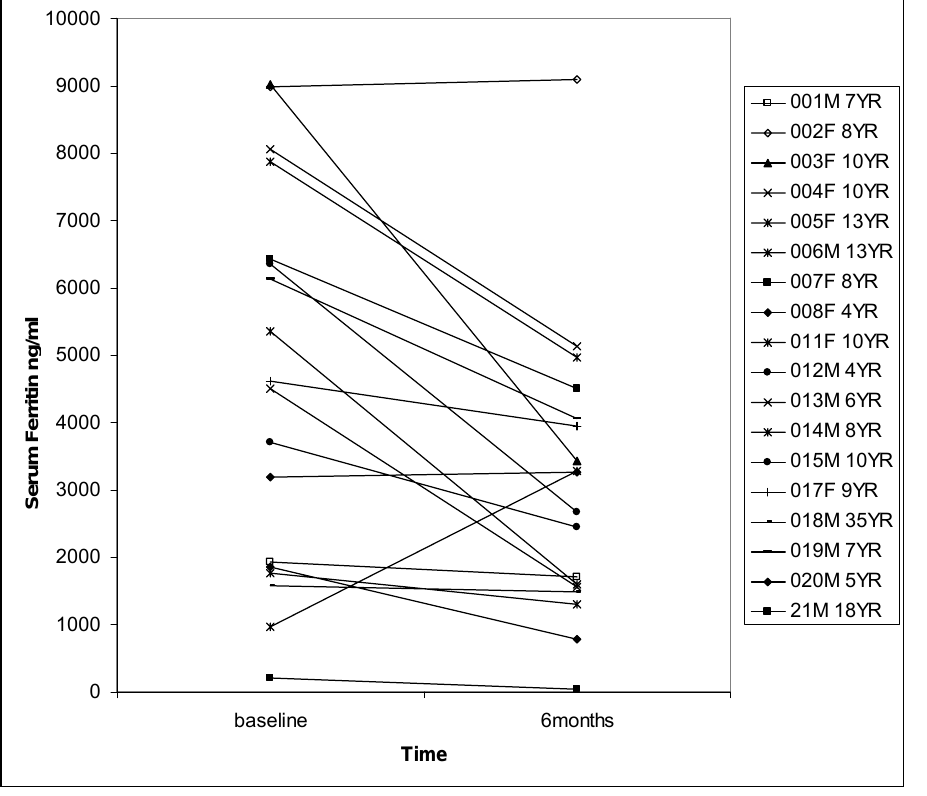
The mean LDH (Table 3) rose to statistically significant levels at 1 ( p = 0.01), 2 ( p = 0.04), 3 ( p = 0.03), and 6 months ( p = 0.02) postinfusion when compared to baseline (Table